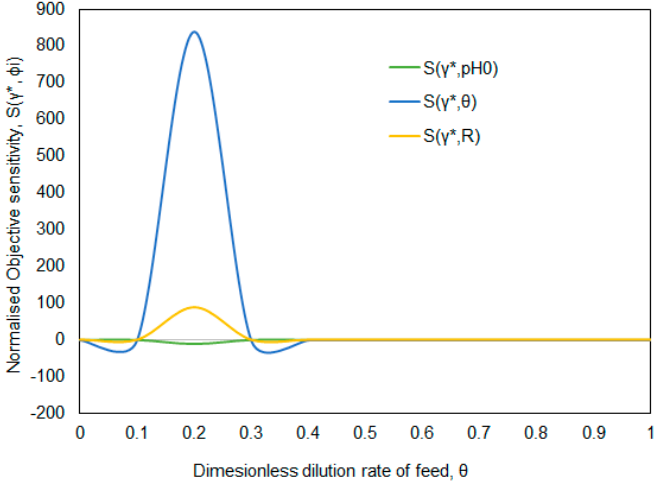
Figure 3. Normalized objective sensitivities S( γ *, ϕ i ) as a function of base stream dilution rate θ .